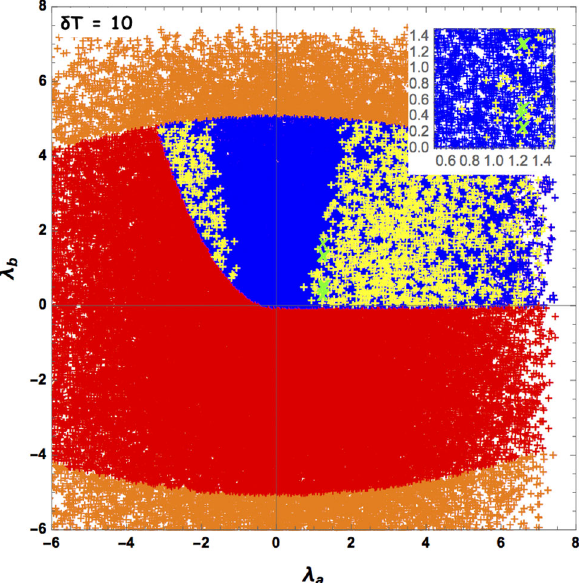
Fig. 10 The allowed regions in ( λ a ,λ b ) for δ T = 10 in the degenerate case. Color codes are as follows, orange: Excluded By Unitarity Con- straints. Red: excluded by unitarity+BFB constraints. Blue: excluded μ ≈ 4 v by Unitarity+BFB & t constraints. Yellow: Excluded by Uni- λ μ ≈ 4 v tarity+BFB & T d ≈ δ T ∧ T t ≈ δ T & t constraints. That shows λ only the green area obeys ALL constraints. Our inputs are λ = 0 . 52, − 5 ≤ λ